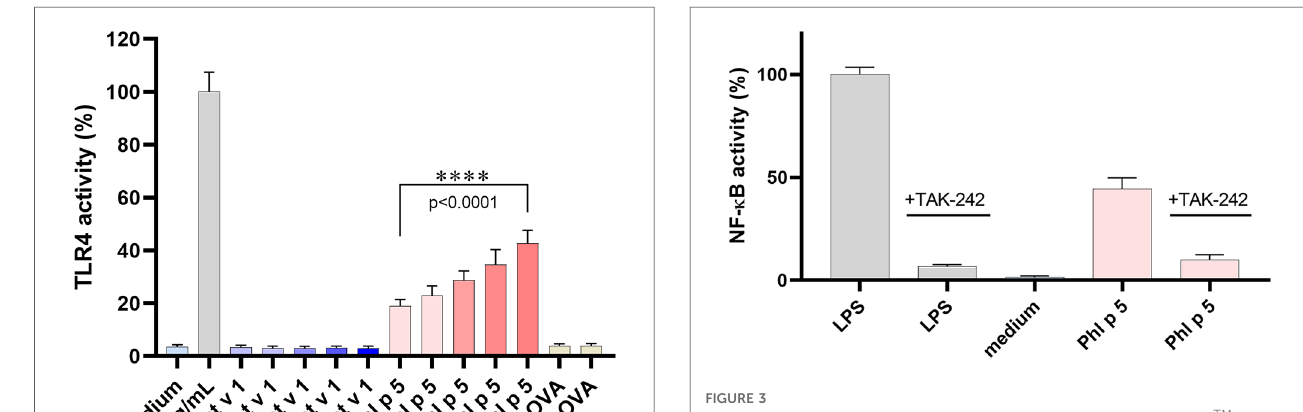
FIGURE 3 NF- k B activation by native Phlp5. NF- k B activity in THP-1-Lucia TM NF- k B cells normalized to LPS and inhibition experiments with TLR4 antagonist TAK-242. Arithmetic mean values and standard deviations of three independent experiments performed in triplicates (samples without TAK-242) or in duplicates (samples with